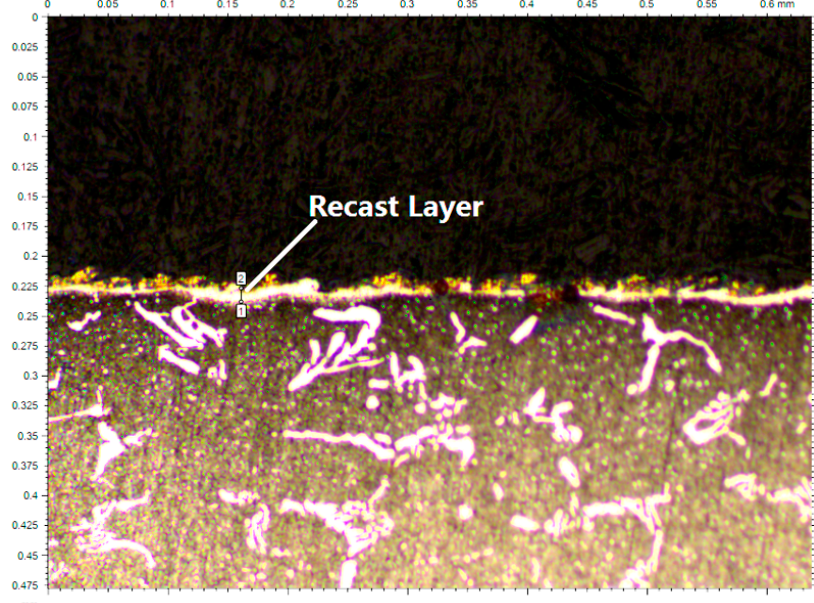
Figure 9. Recast layer after WEDM under the conditions described in Table 1.